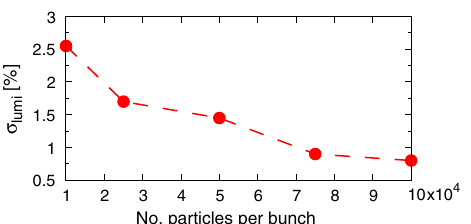
FIG. 7. Obtained luminosity error assuming an error-free CLIC-FFS lattice as a function of number of particles in the bunch. Each dot is the standard deviation of 100 luminosity calculations obtained by GUINEA-PIG after tracking 100 differ- ent